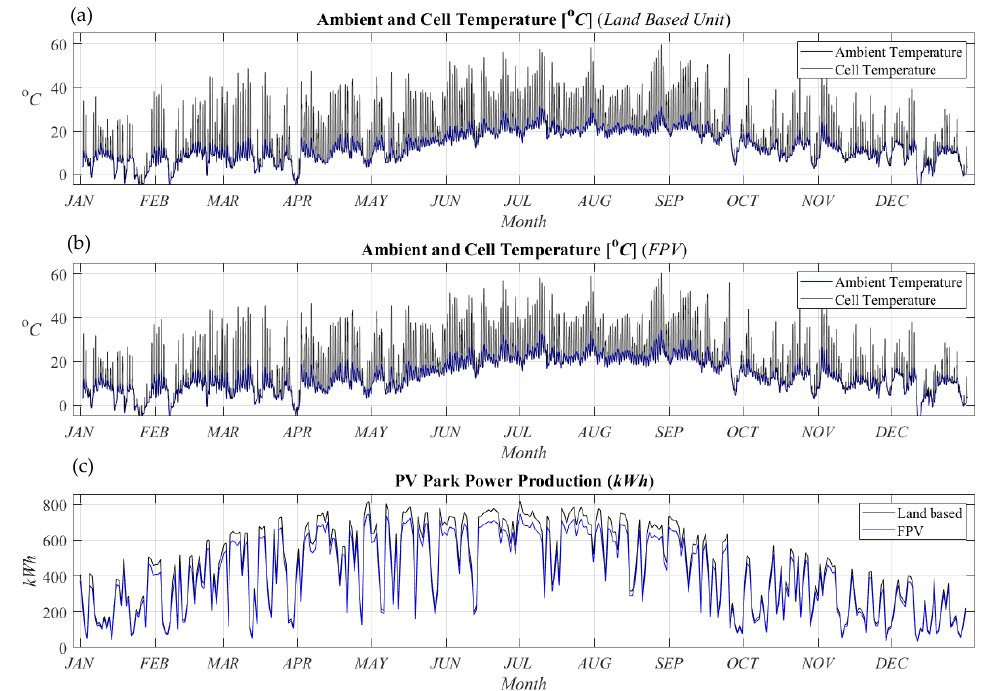
Figure 12. Simulated time series of temperature and power performance for land-based and FPV 100 kWp configuration considered at the geographical location of the SE Evia Island nearshore region. Ambient and cell temperature of ( a ) land-based unit and ( b ) FPV, and ( c ) comparative daily power production in a TMY.